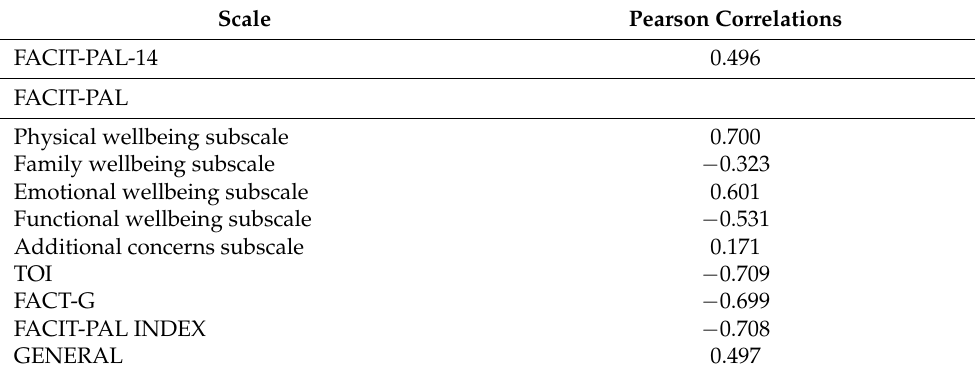
Table 4. Criterion validity with